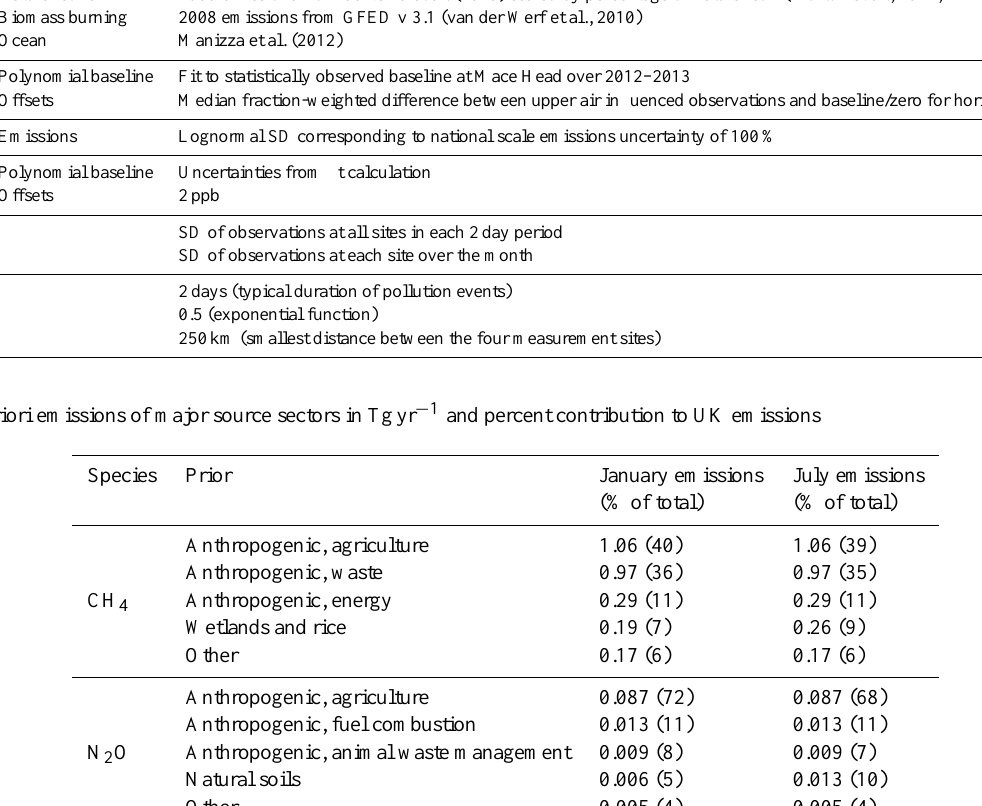
Table 2. Same as Table 1 but for N 2 O. Parameter Category Prior